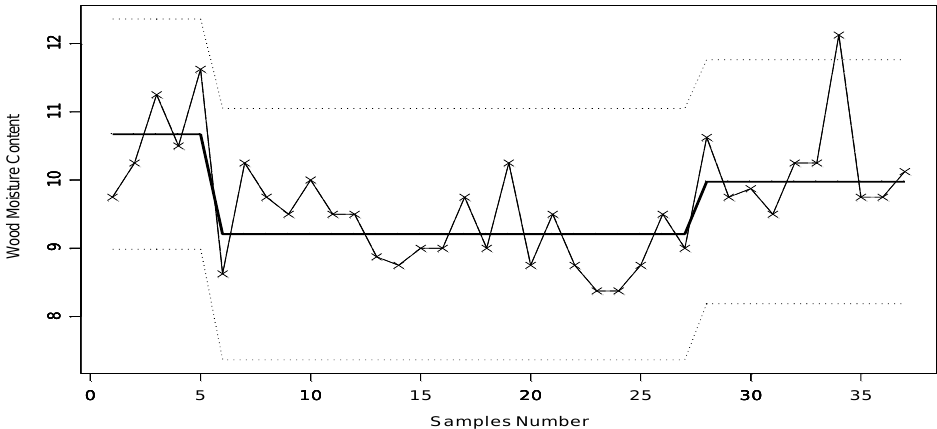
Fig. 4. The proposed robust individuals control chart for wood moisture content using M-scale